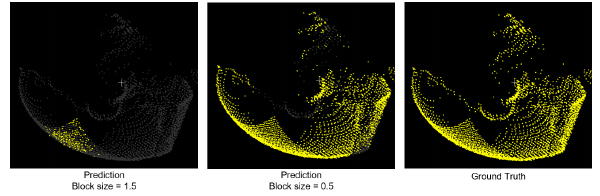
Figure 5. Results of PointCNN on the surveillance cameras using two different block